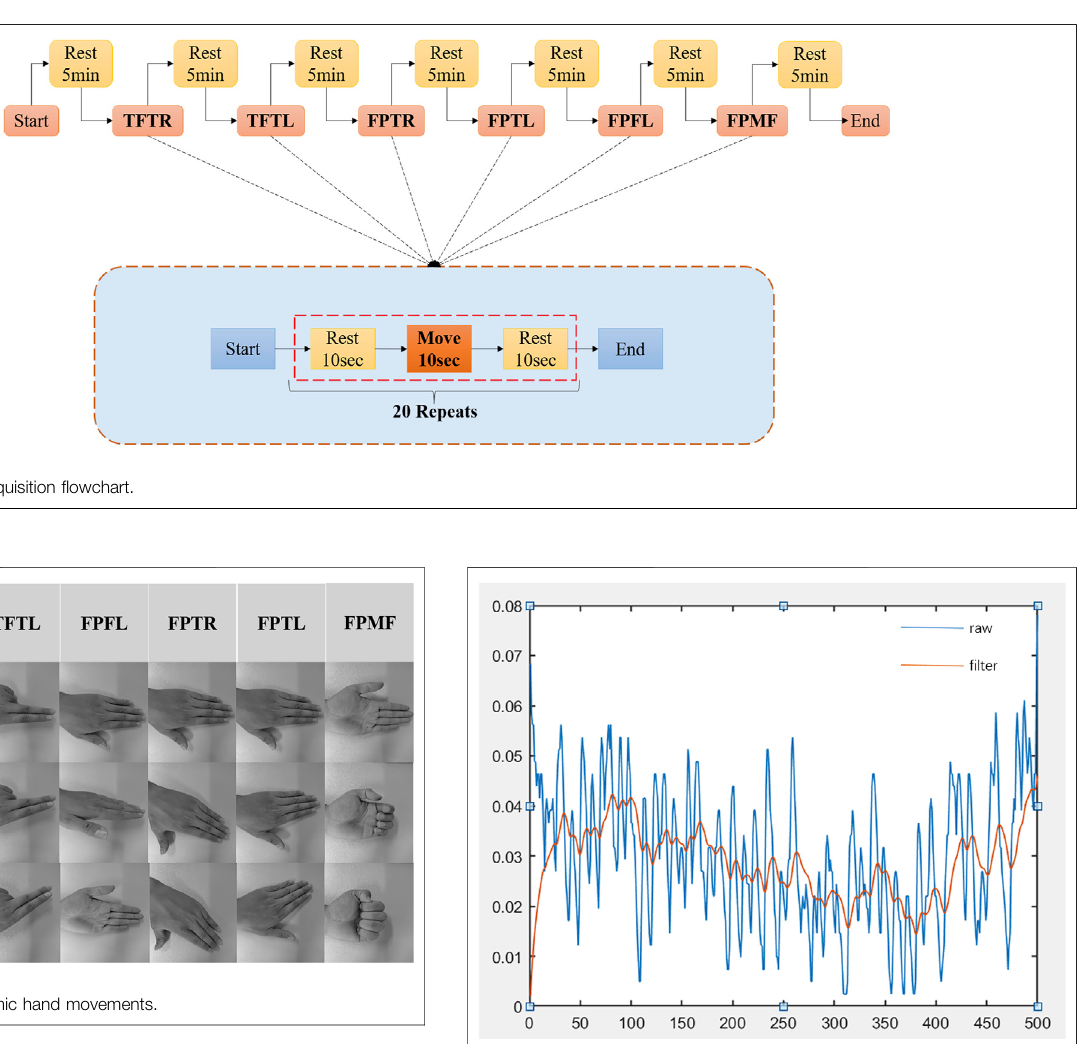
FIGURE 9 | The timing diagram of sEMG.